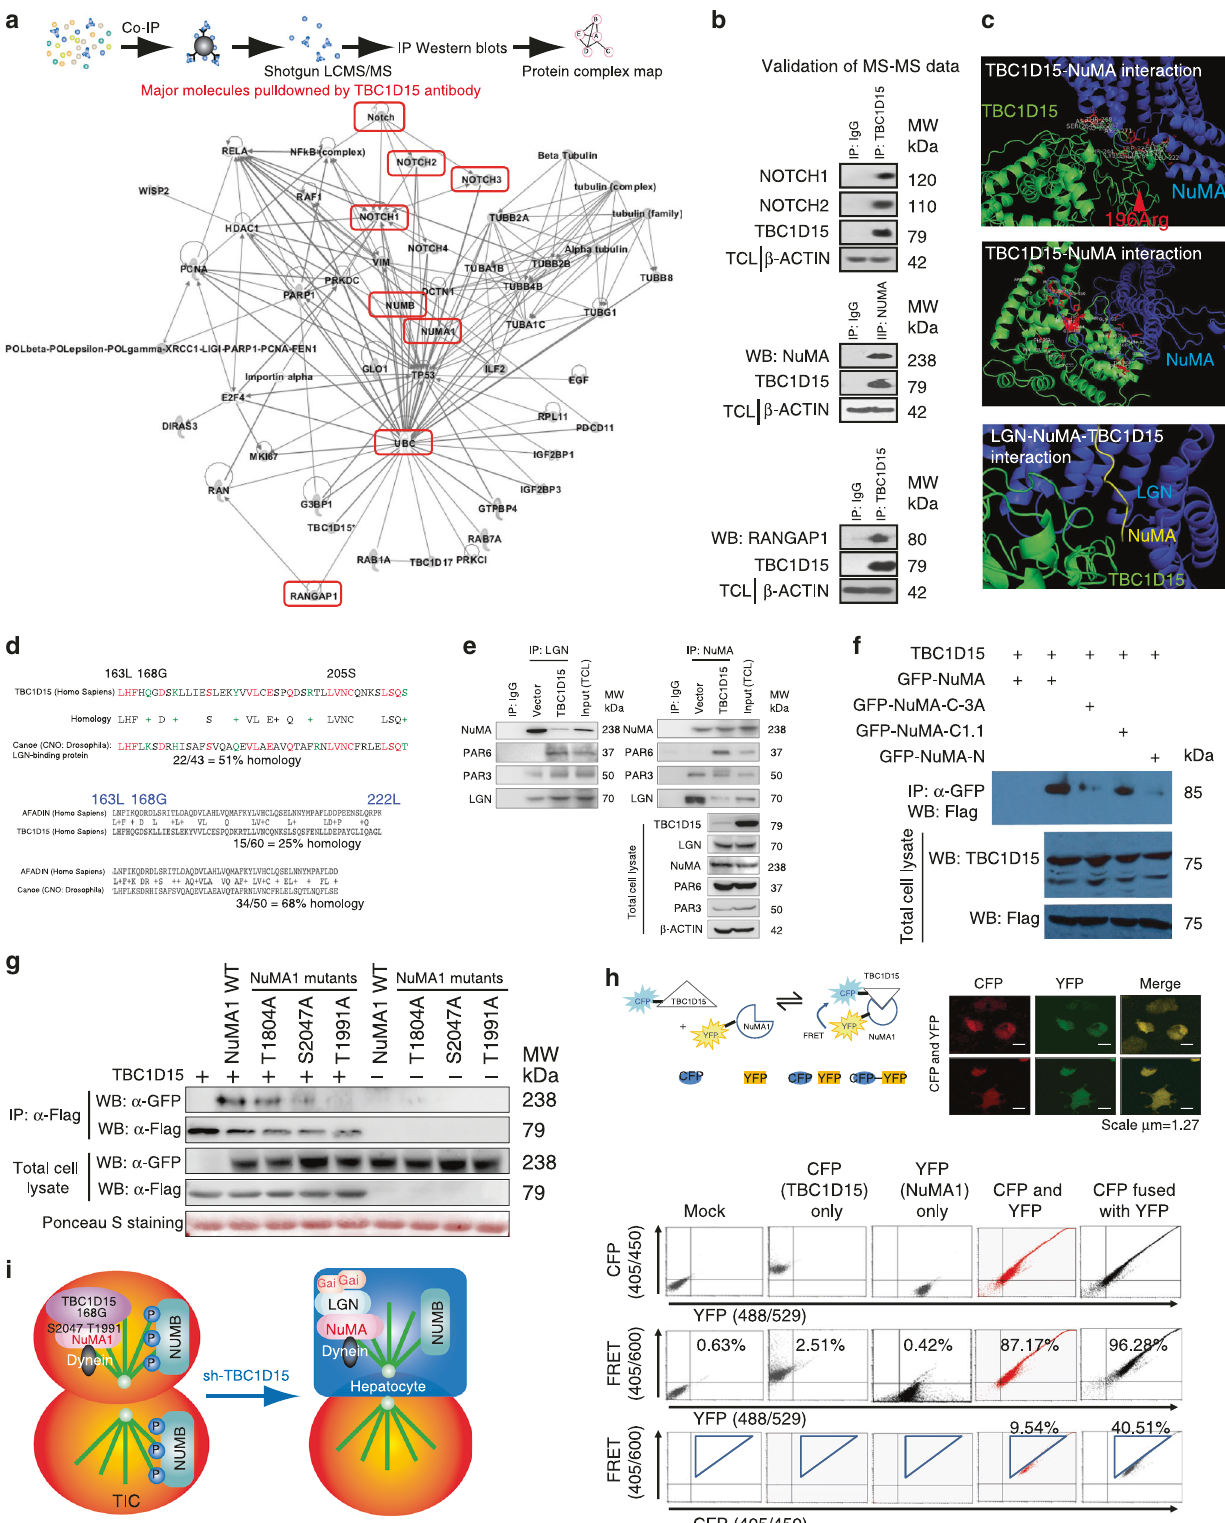
generate TICs, leading to HCC development. Normal liver pro- genitor cells (LPC) differentiate into either cholangiocytes or hepatocytes through NOTCH signaling or NUMB-mediated signaling, respectively (Fig. 3c). This expression signature was associated with a high propensity for liver cancer development